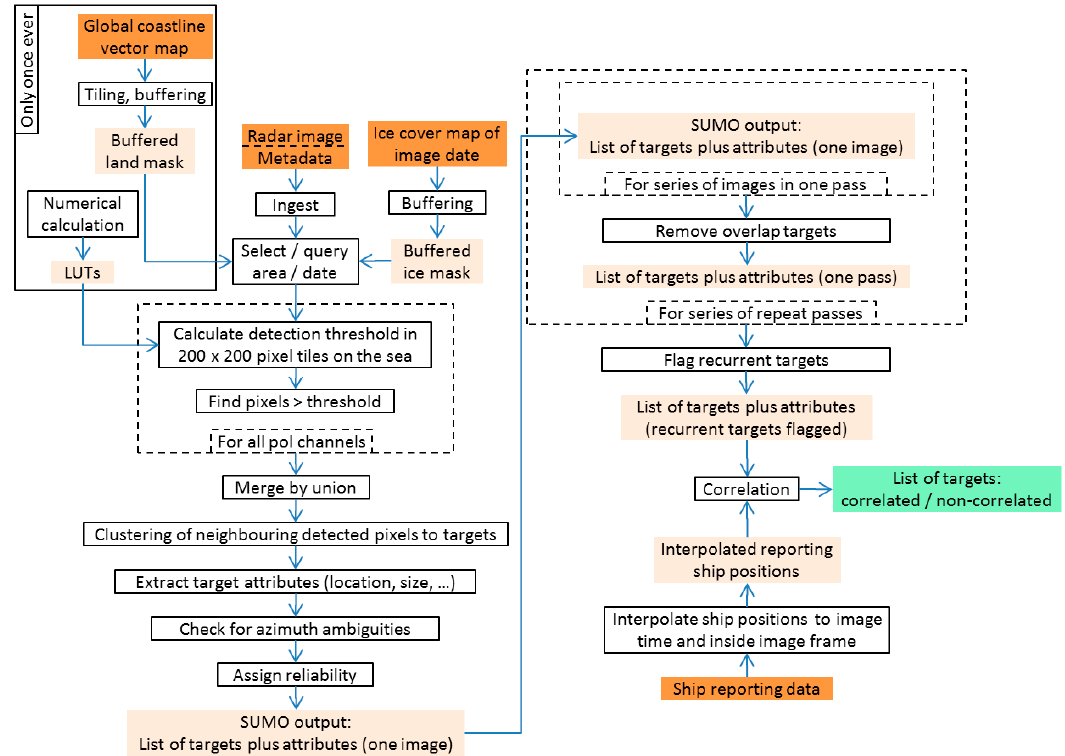
Figure 4. Flow chart of the SUMO algorithm and its environment. Outlined boxes are processes; text on a color background without an outline signifies data. A dashed box contains a process that is to be repeated as mentioned. The four dark orange colored boxes are the external data that go in. The green box on the right is the final result that comes out. The left half is SUMO proper, which works on a single SAR image. The box at the top left contains a section that needs to be executed only once, whereas the rest is run for each image again. Land mask and ice mask are of course only needed if there is land/ice in the image. The right half depicts the use of multiple images in a maritime surveillance campaign and the combination with ship reporting data.